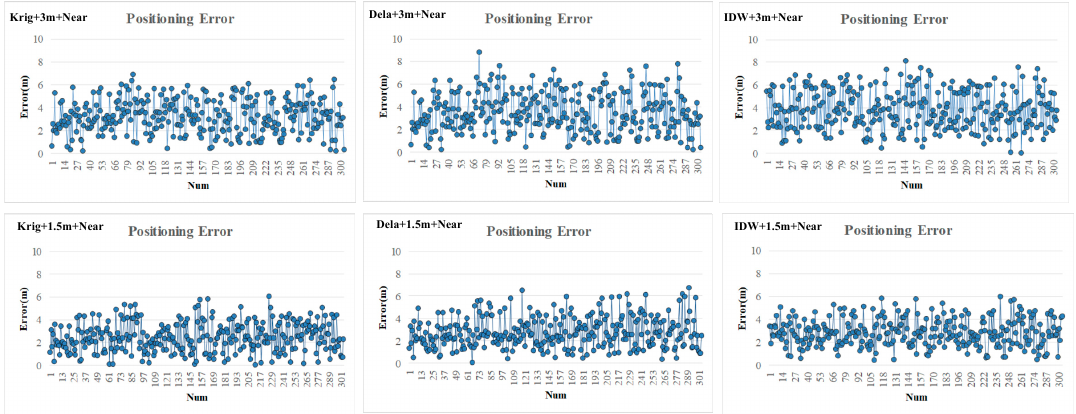
Figure 12. Positioning error with the different interpolation methods (IDW and Delaunay) and interpolation densities (3 and 1.5 m) considering the near relation. Table 2. Positioning error statistics considering the near relation.